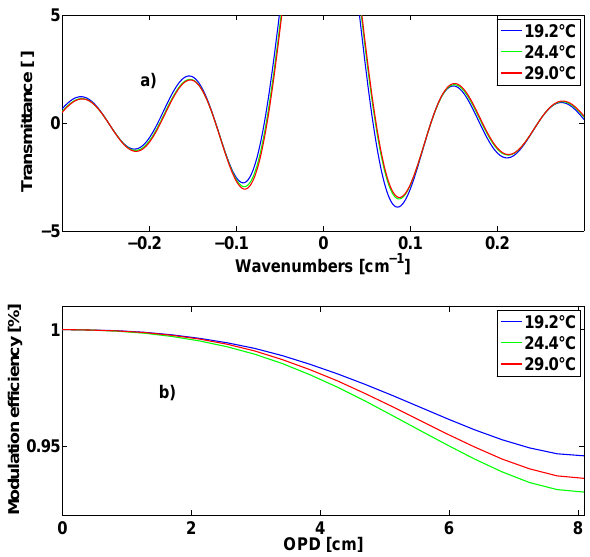
Fig. 1. Linefit evaluation with a HCl gas cell for different temper- atures. Panel (a) shows the ILS (the line is truncated to show the important part in more detail), (b) shows the modulation efficiency decreasing with the